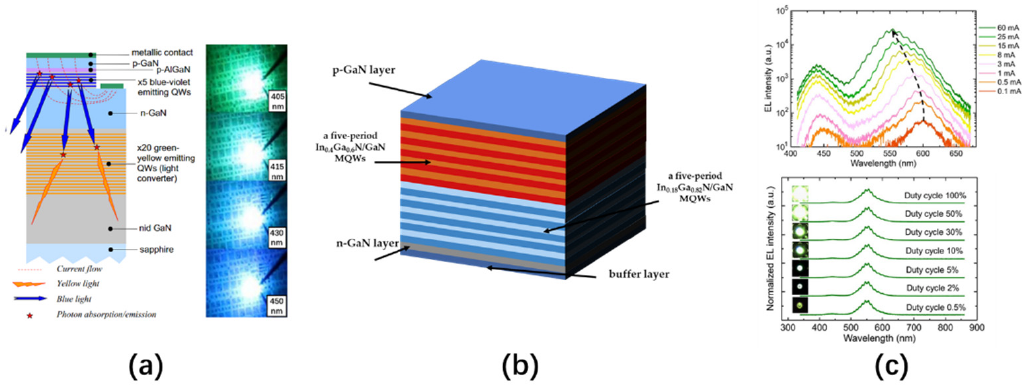
Figure 18. ( a ) The blue LED structure grown on top of InGaN / GaN multiple QWs with light emission under di ff erent wavelength pump light sources proposed by Damiano et al. Reproduced from [104], with permission from American Institute of Physics, 2010; The dual active area micro-LED structure proposed by the Dawson team with a high In mole fraction up to 0.4 ( b ), and its ( c ) EL spectrum in using di ff erent injection currents and the brightness change of the LED under di ff erent duty cycles of the driving voltage ( c ). Reproduced from [106], with permission from Institute of Electrical and Electronics Engineers, 2012.